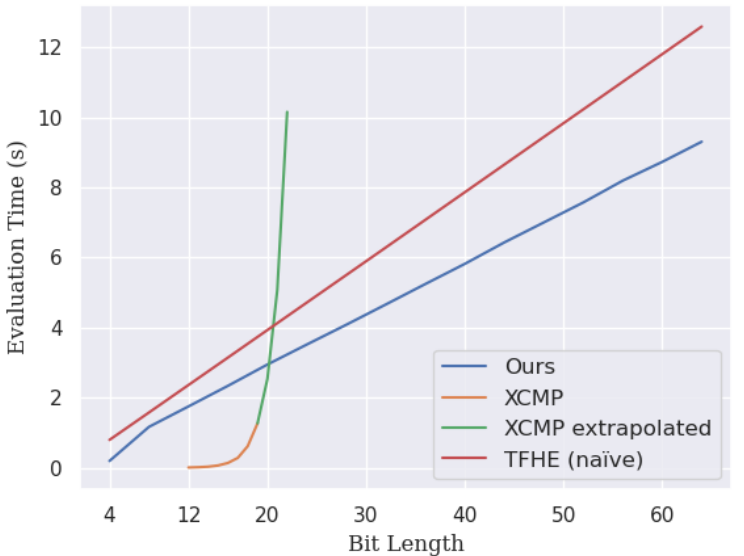
Figure 12. Evaluation time of our comparison method, TFHE [3] and XCMP [6], for comparing two encrypted value aspects to various bit lengths.